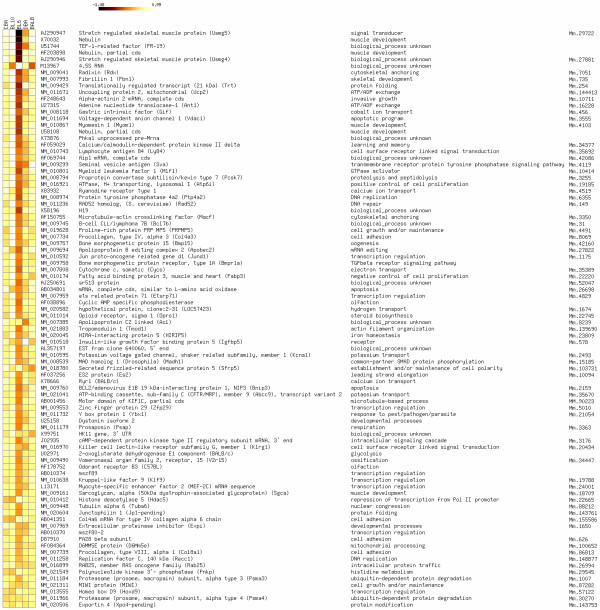
Differentially expressed genes between mouse inbred strains Relative expression levels of differentially expressed genes between mouse inbred strains are depicted in colour as relative intensity levels. Shown for each gene are GenBank accession number, description, functional annotation according to Gene Ontology, and UniGene cluster IDs. Relative expression levels are calculated by subtracting the average intensity value per gene from the strain-dependent intensity values. Differential expression was determined by selecting p-values from analysis of variance based on a false discovery rate of 10%.